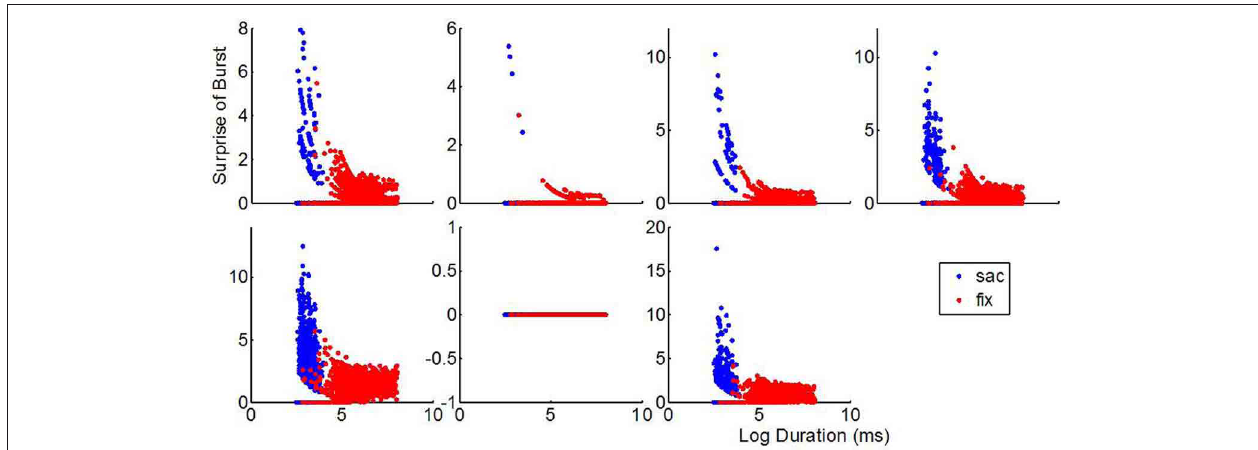
FIGURE 6 | The higher firing and surprise of bursts during fixations with respect to saccades is not due to fixations lasting longer. Surprise of the bursts (ordinates) as a function of the duration of the saccades (blue dots) or fixations (red dots). Each inset corresponds to one of the cells shown in Figure 5 using an identical ordering. Note that bursts are absent for a large